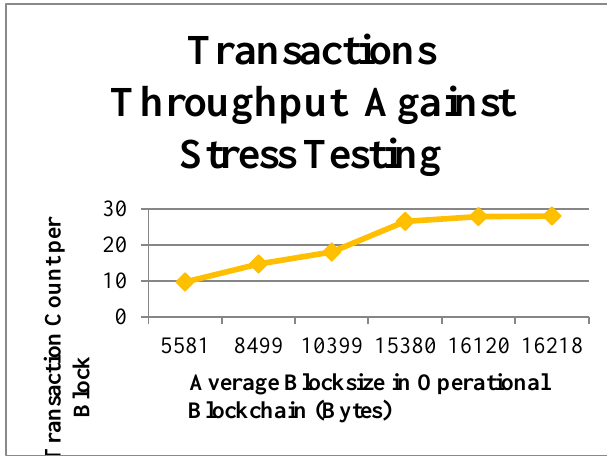
Fig. 8. Scalability for proposed model without